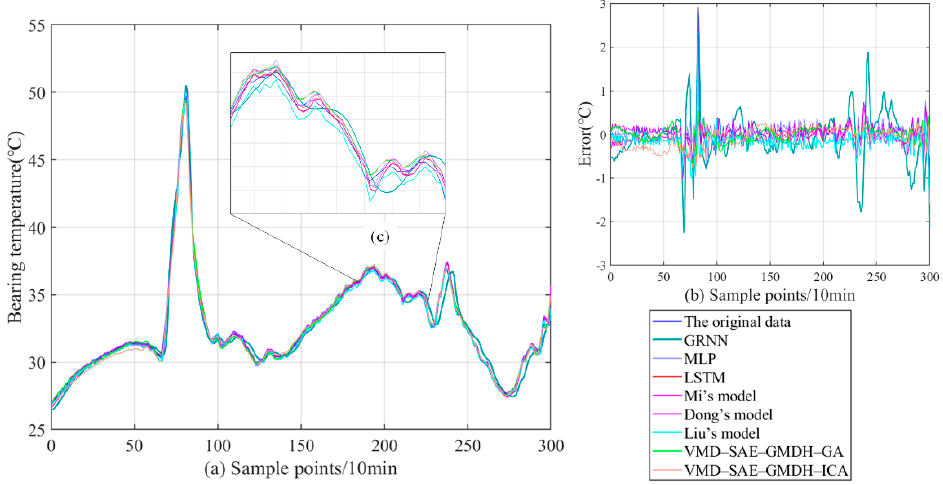
Figure 6. Forecasting results and errors of all models of series #2: ( a ) forecasting results; ( b ) error distribution; ( c ) local enlargement.